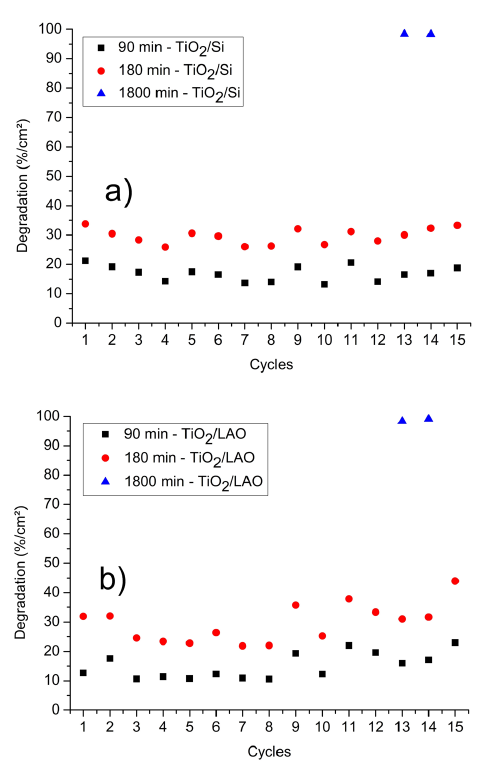
Figure 7. 15 cycles of photocatalysis tests, comparing the degradation rates (%/cm 2 ) at 90, 180, and 1800 minutes of exposure to UV light irradiation, made to evaluate the photocatalytic stability of the TiO 2 film deposited by Sputtering. (a) TiO film deposited on a silicon 2 substrate. (b) TiO film deposited on a lanthanum aluminate 2